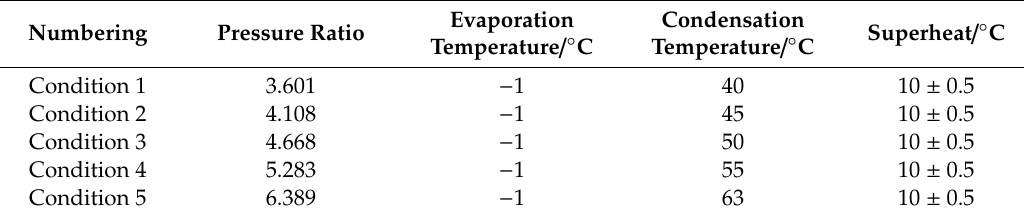
Table 3. Variable pressure ratio experimental operation